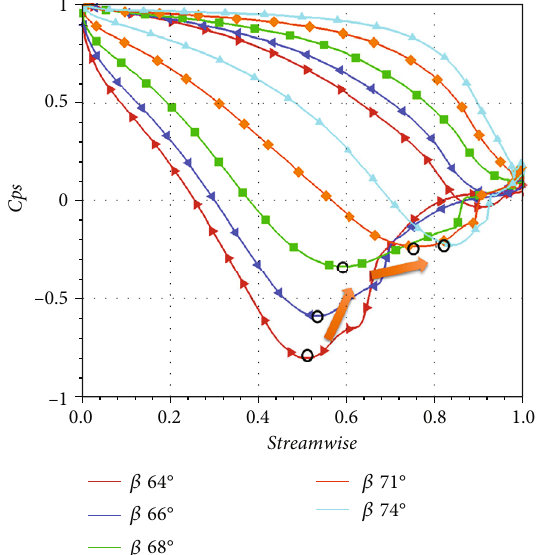
Figure 13: Comparison of static pressure coe ffi cient near the midspan of the blade for di ff erent exit angles.